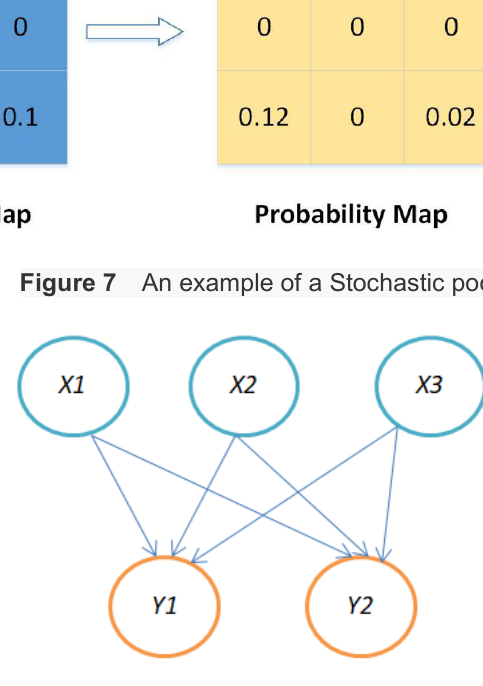
The working principle of the full connection